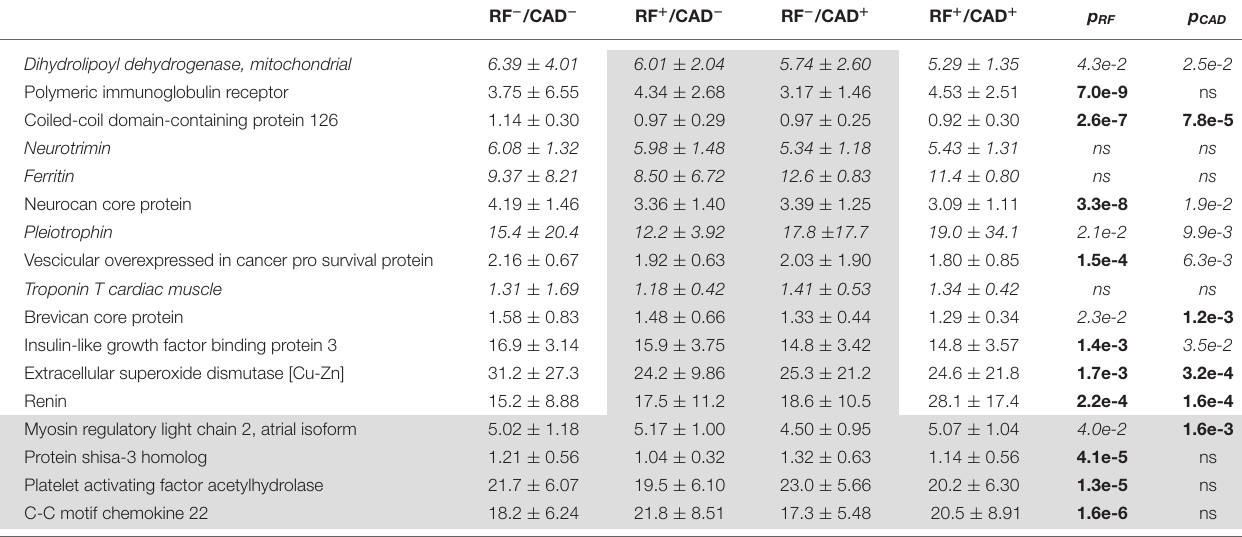
TABLE 3 | Plasma proteins independently associated with cardiovascular risk factors (RF) and coronary artery disease (CAD) * .